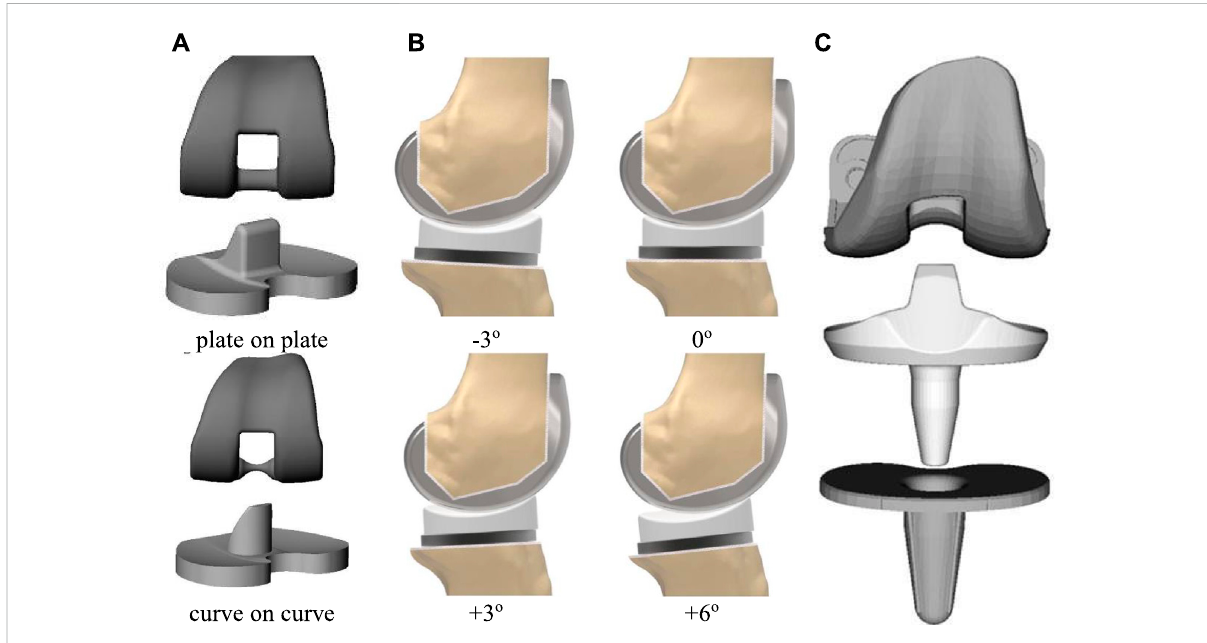
FIGURE 6 Development of tibial insert TKA components, (A) The post-cam stabilizer mechanism (Shimmin et al., 2015), (B) Change of PTS (Kang et al., 2018a), (C) The mobile bearing System (Kurita et al.,